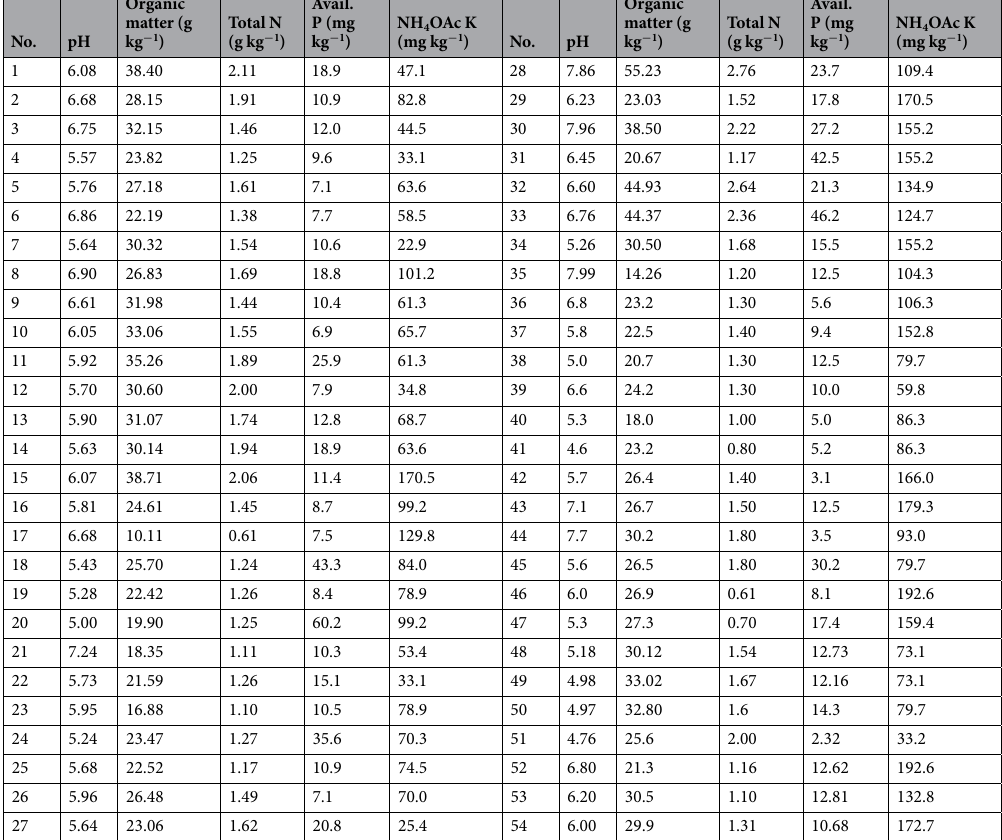
Table 3. Selected properties of the 54 soils included in the trials. Avail.,